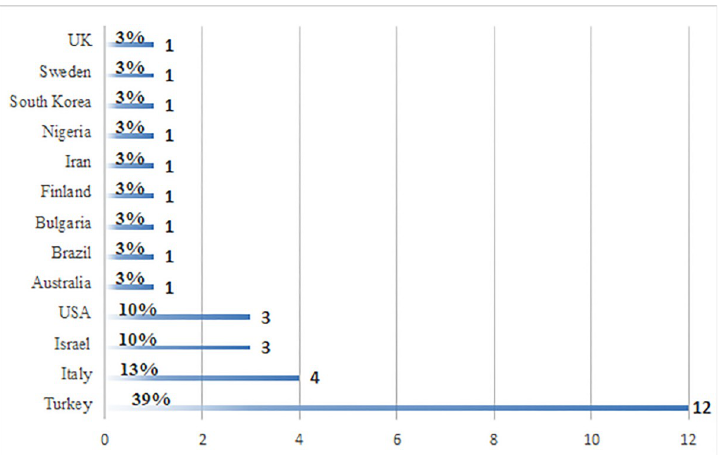
Fig 2. Frequency of included publications by